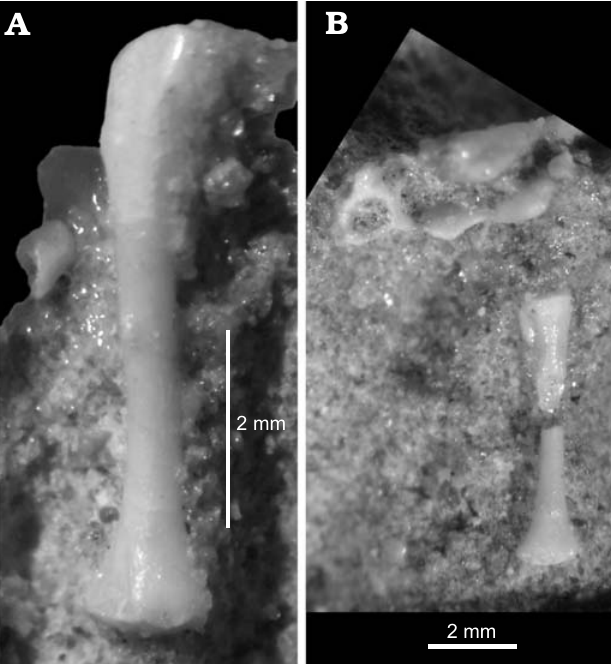
Fig. 10. The stem-amphisbaenid Slavoia darevskii Sulimski, 1984 (ZPAL MgR-I/9) from late Campanian of Mongolia. A . Left femur in posterior view. B . Tibia in posterior